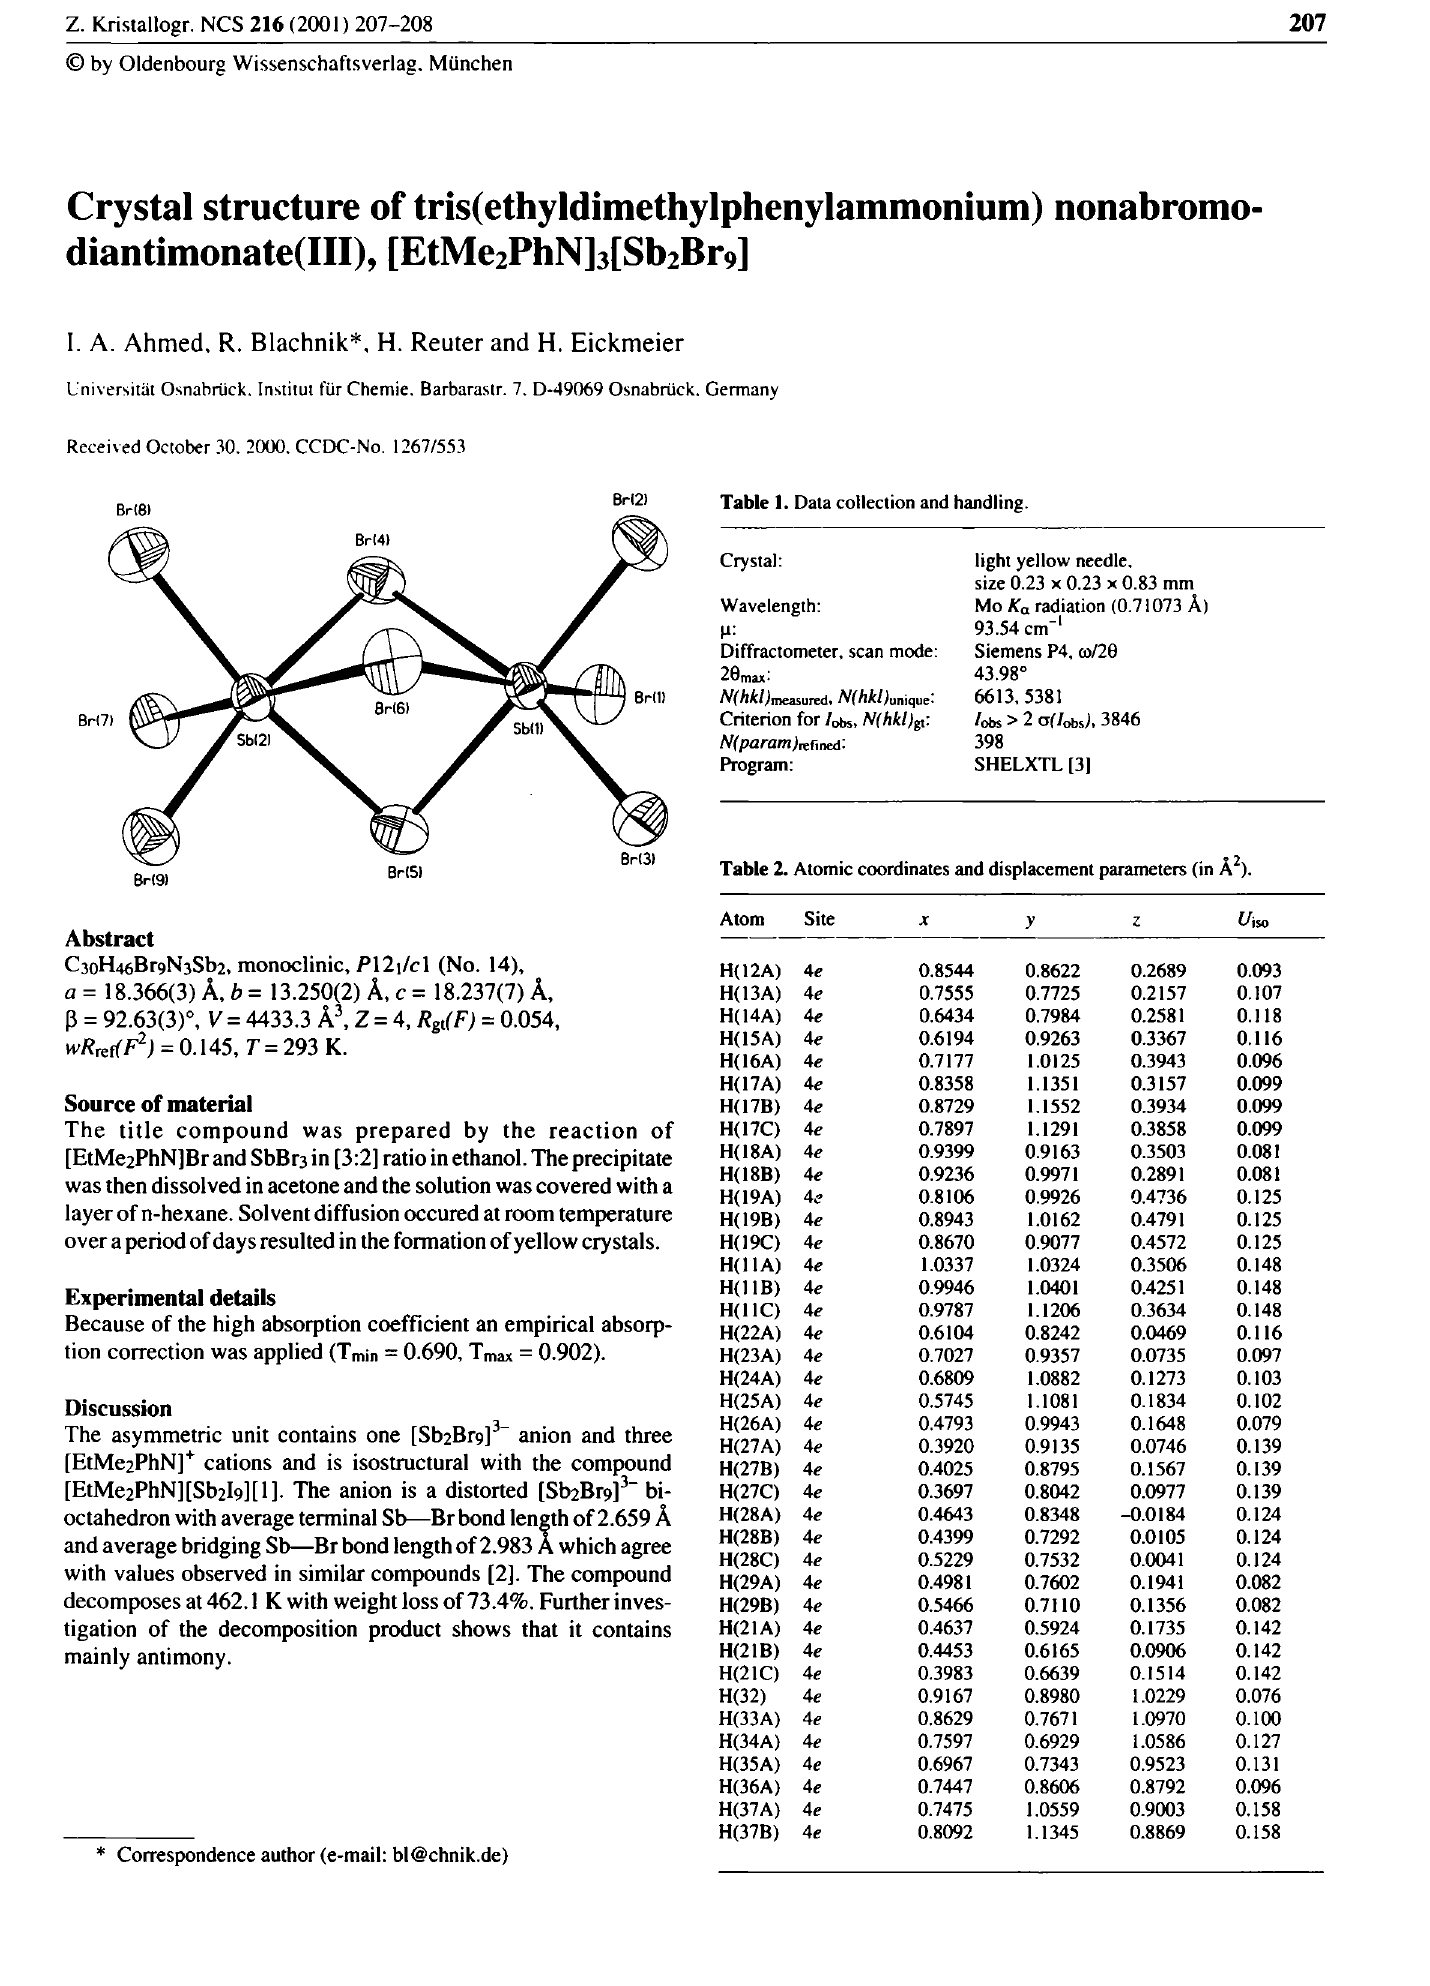
Table 1. Data collection and handling.